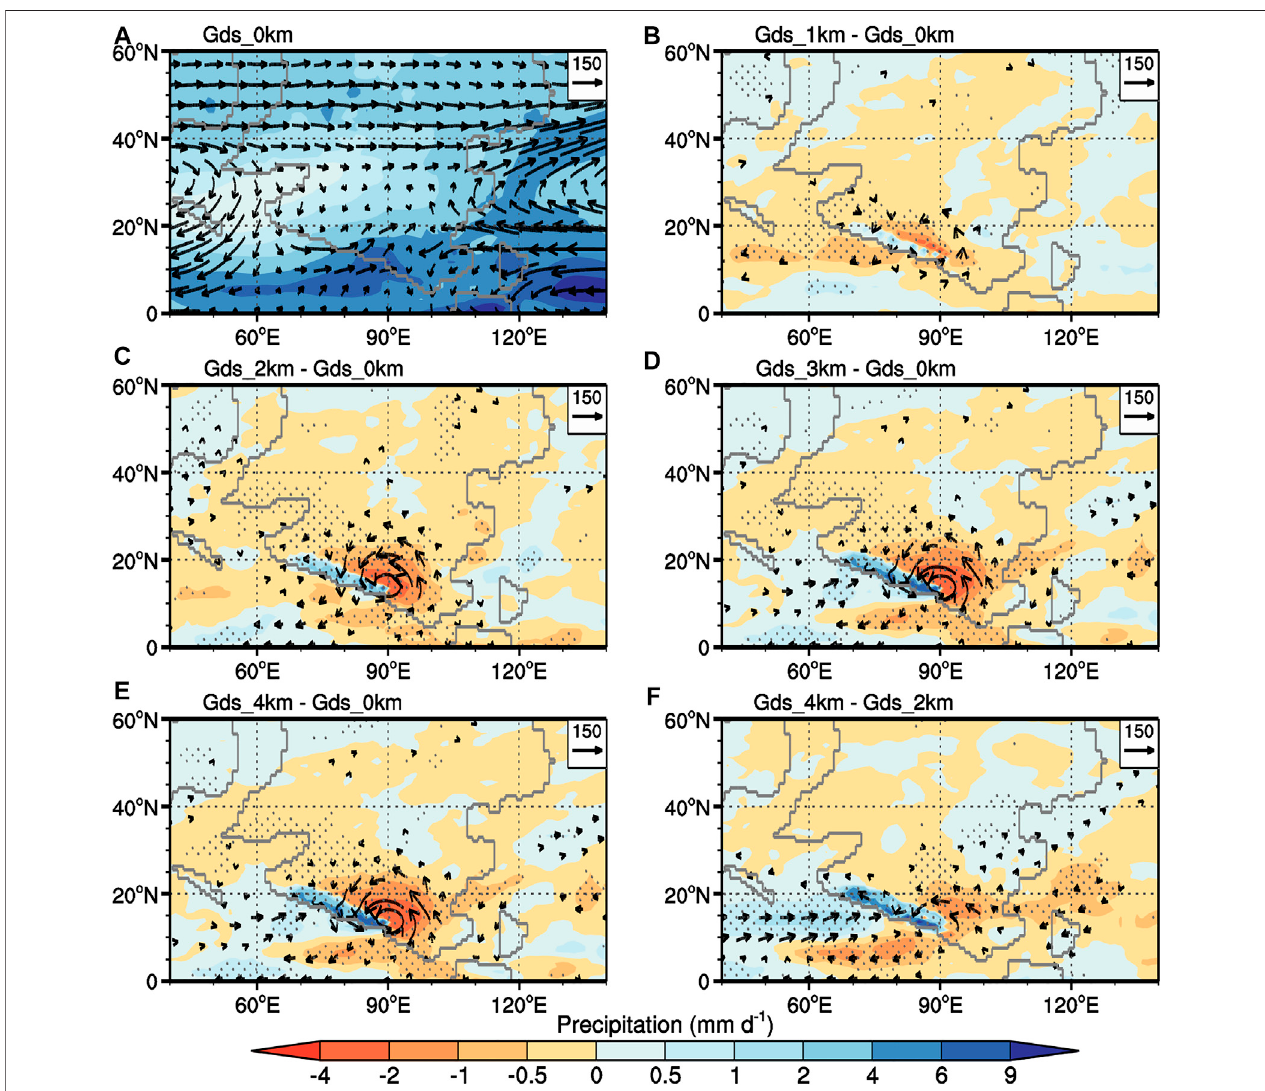
FIGURE4| Annualmeanprecipitation(shaded;units:mm d − 1 )andverticallyintegratedwatervaportransport(vectors;units:kg m − 1 s − 1 )ofexperimentGds_0 km (A) and their differences between experiments Gds_1 km and Gds_0 km (B) , Gds_2 km and Gds_0 km (C) , Gds_3 km and Gds_0 km (D) , Gds_4 km and Gds_0 km (E) , and Gds_4 km and Gds_2 km (F) . In (B – F) , only the areas with con fi dence levels > 95% (using the Student ’ s t-test) are presented for the water vapor transport and dotted for the